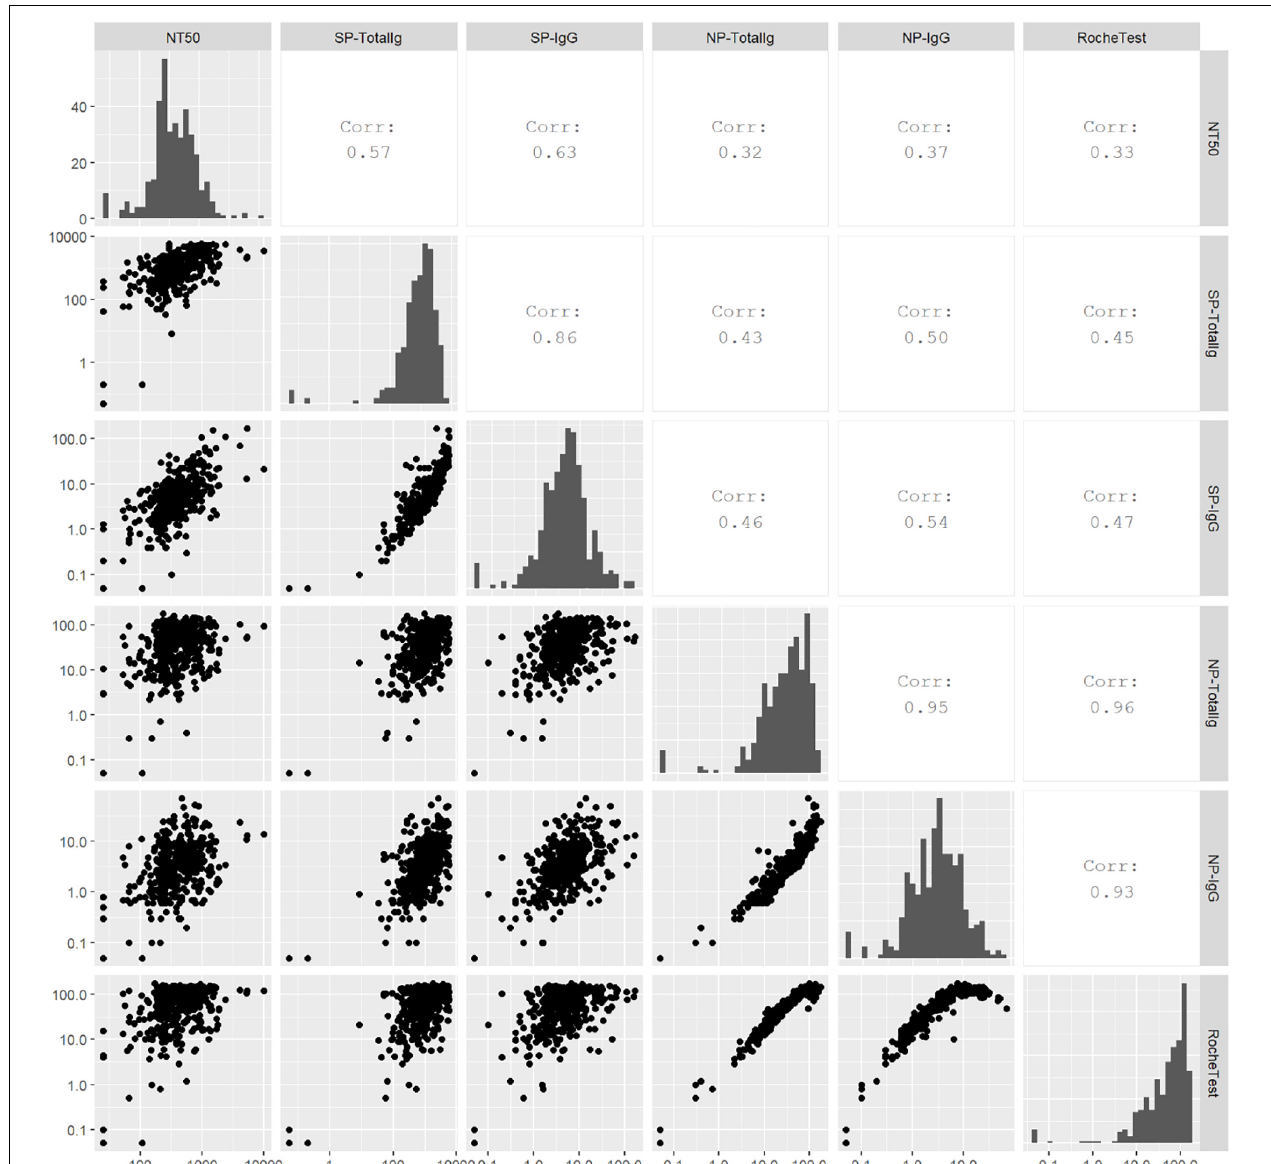
FIGURE 2 | Scatter plots, Spearman’s correlations, and histograms for antibody titers. Spearman’s correlation was calculated to examine correlations among neutralizing titers (NT 50 ), SP-total Ig, SP IgG, NP-total Ig, NP IgG, and Roche NP-total Ig. Higher value represents stronger